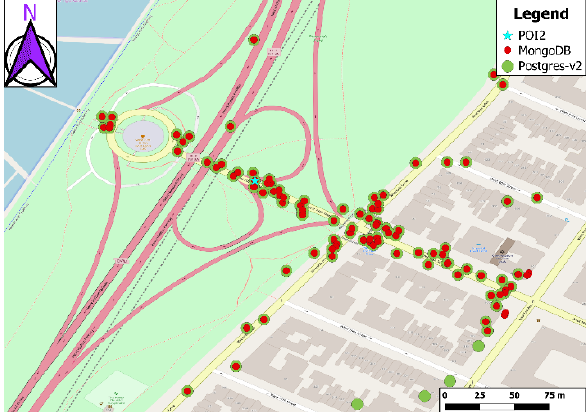
Figure 14 The biggest maximum Vincenty distance